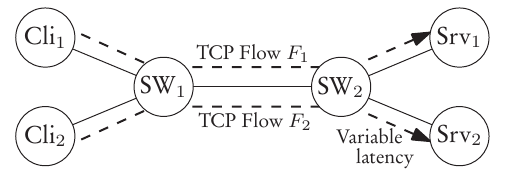
Figure 2: Dumbbell topology